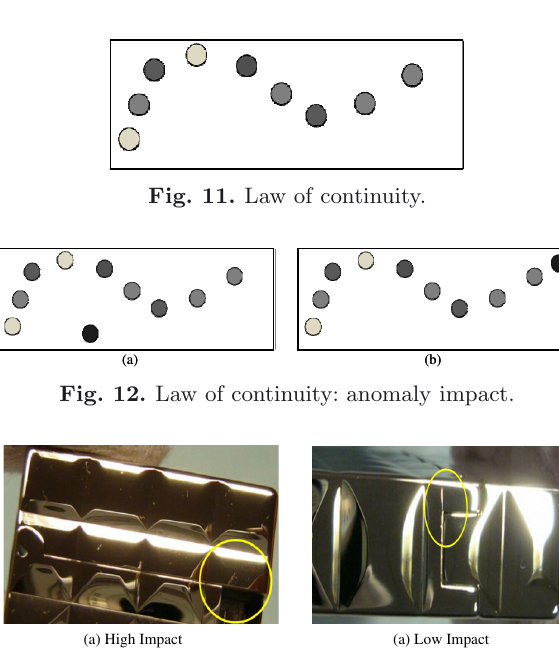
Fig. 7. An anomaly in the case of non-similar objects.